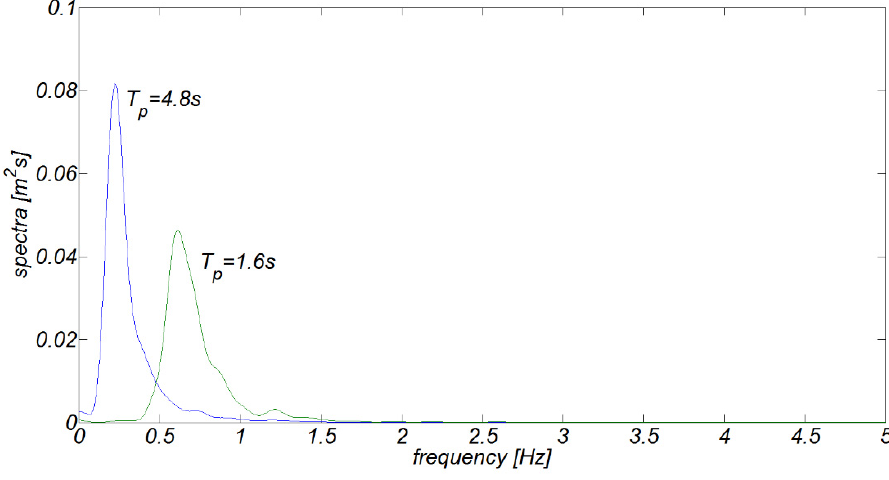
Figure 3. Comparison of wave crest distribution of nonlinear random waves of finite bandwidth with linear counterpart by Cartwright and Longuet-Higgins [33]. Figure 4 shows the evolution of wave crest distribution as nonlinearity is enhanced. It is shown that the probability density mass spreads toward the larger and smaller waves as nonlinearity is increased [38].